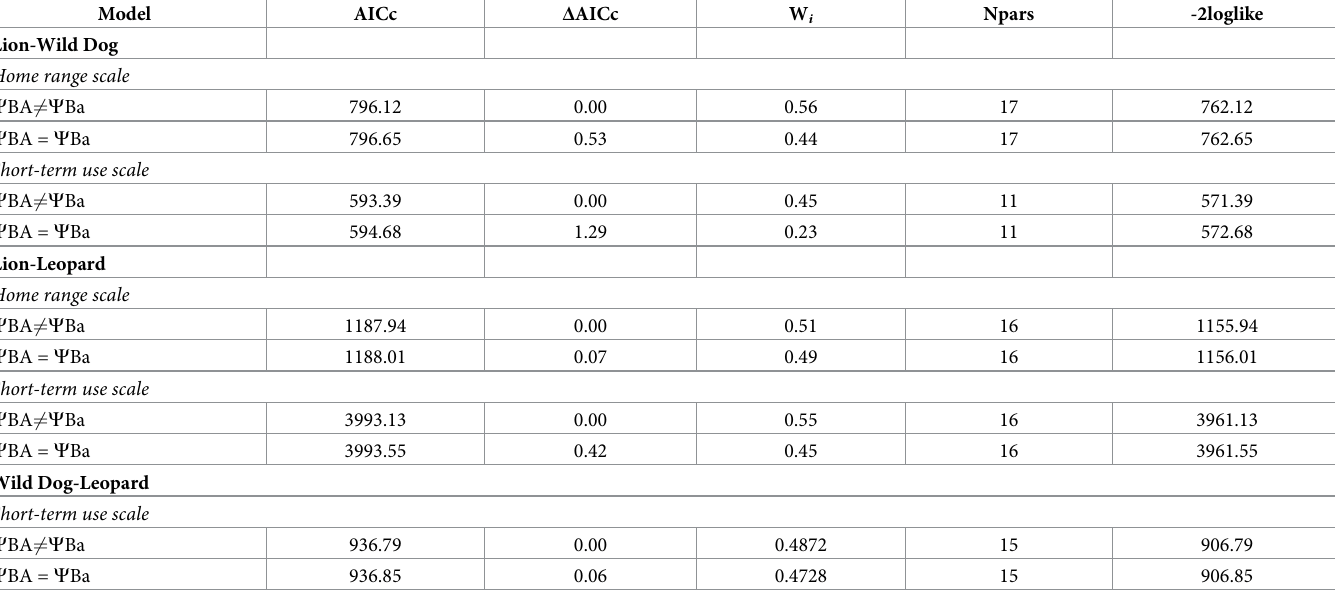
Table 1. Summary of co-occurrence model rankings used to evaluate the role of interspecific interactions on occurrence of lion, leopard, and wild dog in Ruaha- Rungwa, at two spatial scales. Models in which site use of the subordinate species depends on the presence ( C BA) or the absence ( C Ba) of the dominant species (condi- tional models, denoted as ψ Ba 6¼ ψ BA) were compared against models in which site use of the subordinate species is independent of the presence of the dominant species (unconditional models, denoted as ψ Ba = ψ BA). For each analysis, only the best-supported conditional and unconditional models are presented; see S2 Appendix for full model rankings.